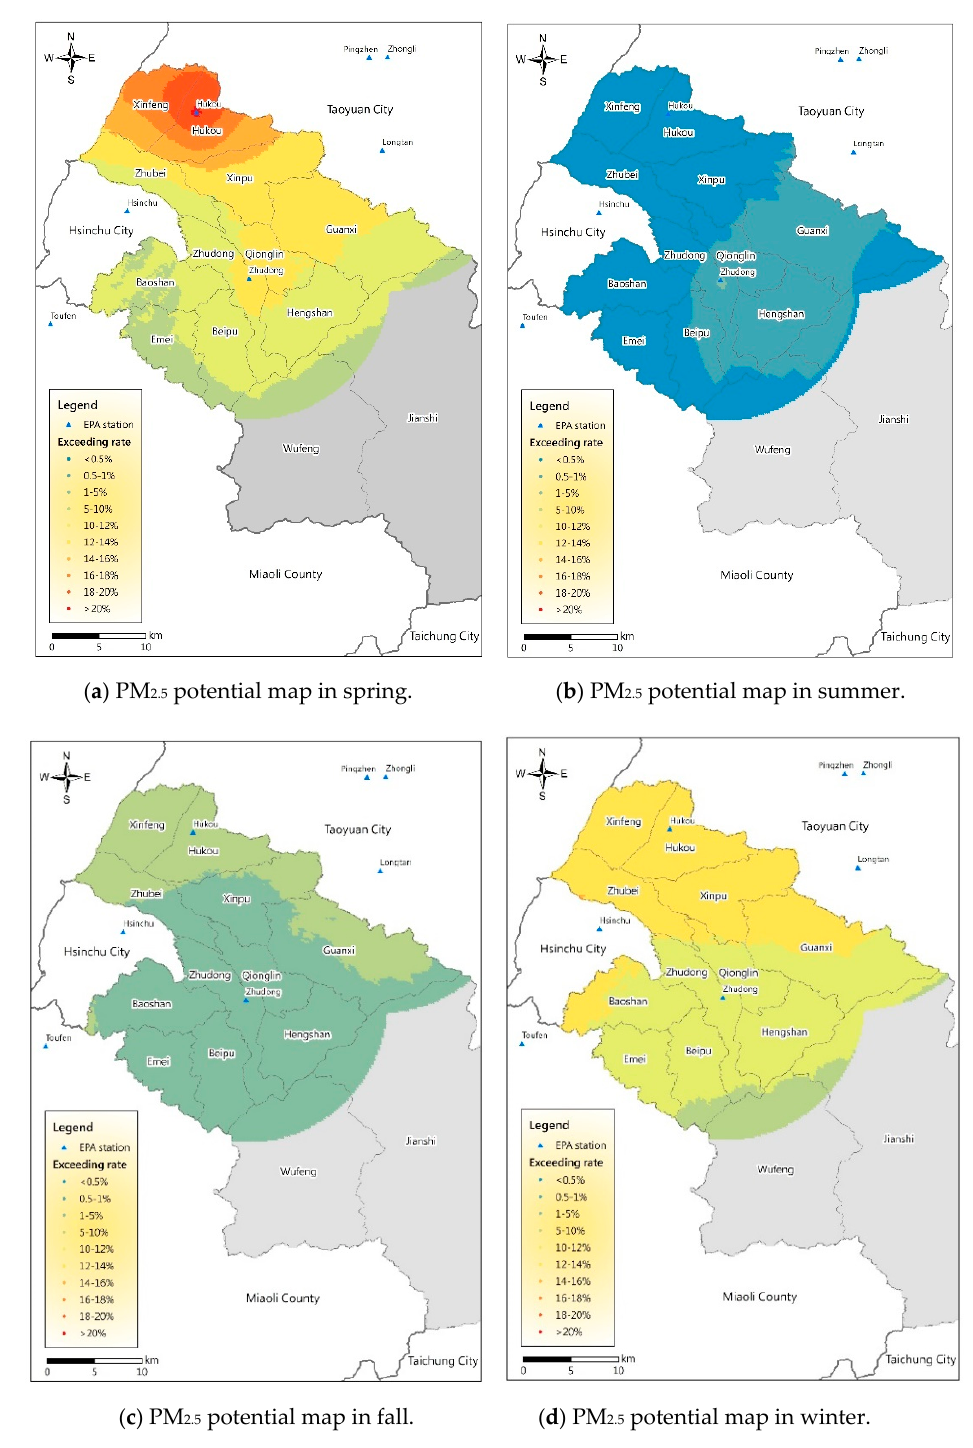
Figure 3. Distribution of PM 2.5 potential in the study area in Hsinchu County in different seasons. Overall, 76 air quality-monitoring stations of the Taiwan Environmental Protection Administration (TWEPA) across the whole of Taiwan were used for spatial estimation, and we extracted the region of Hsinchu County for further analysis. ( a ) PM2.5 potential map in spring. ( b ) PM2.5 potential map in summer. ( c ) PM2.5 potential map in fall. ( d ) PM2.5 potential map in